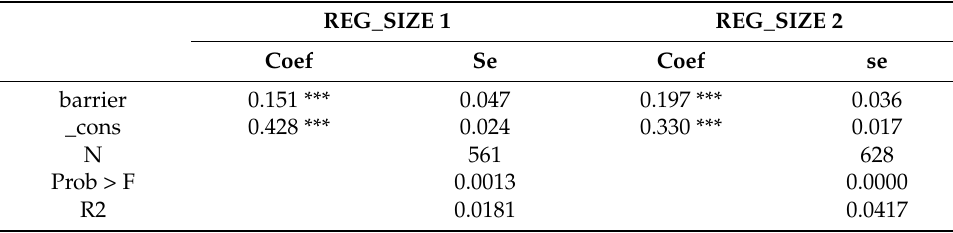
Table 7. Results of the linear regression estimate of the Barrier